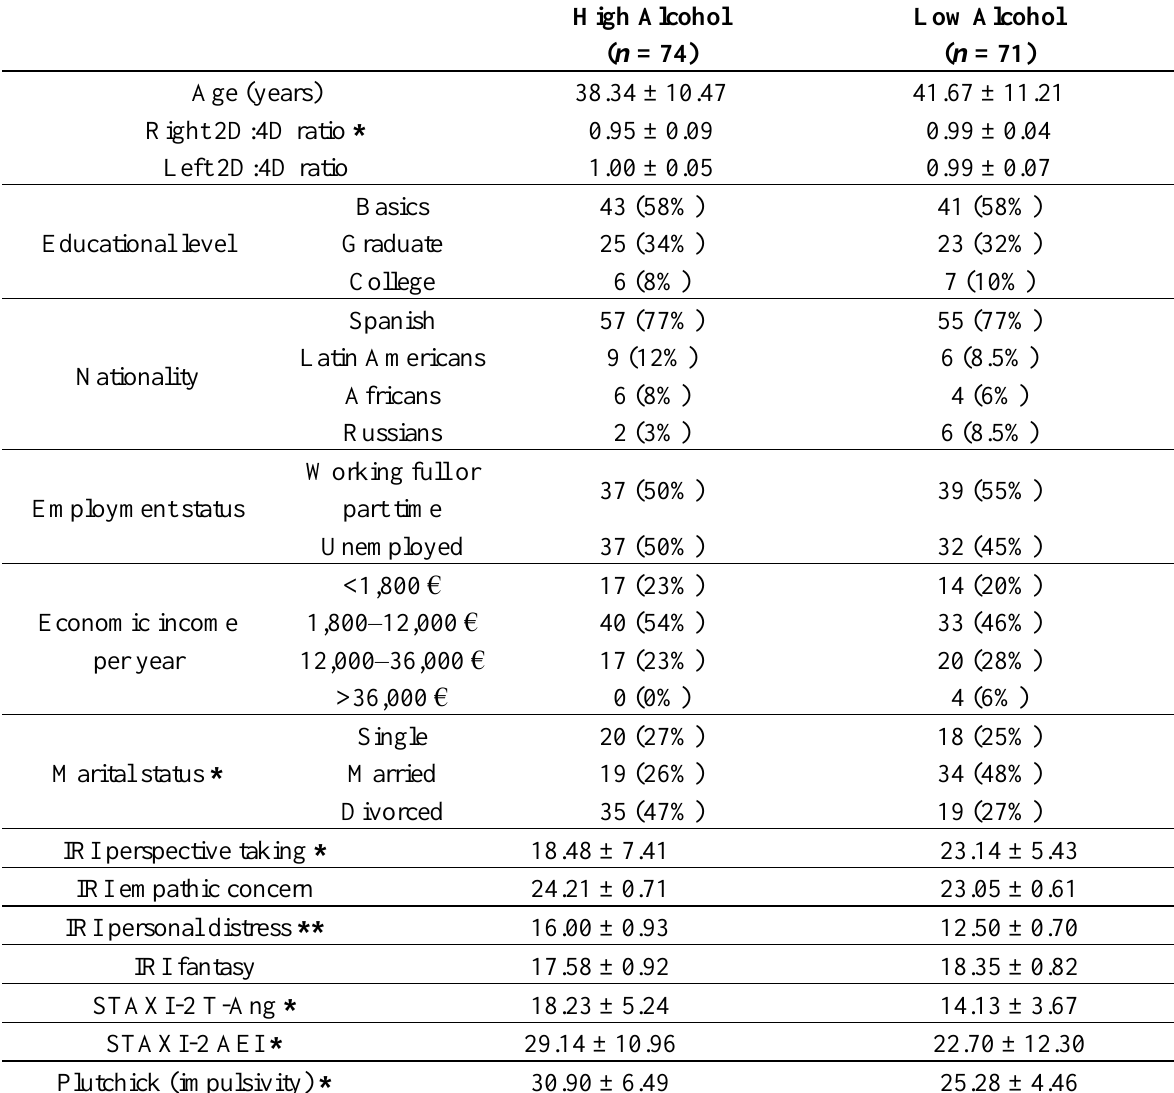
Table 1. Mean ± SEM of descriptive characteristics, psychological trait profiles and neuropsychological variables for High Alcohol (HA) and Low Alcohol (LA) IPV perpetrators. * p < 0.05; ** p <